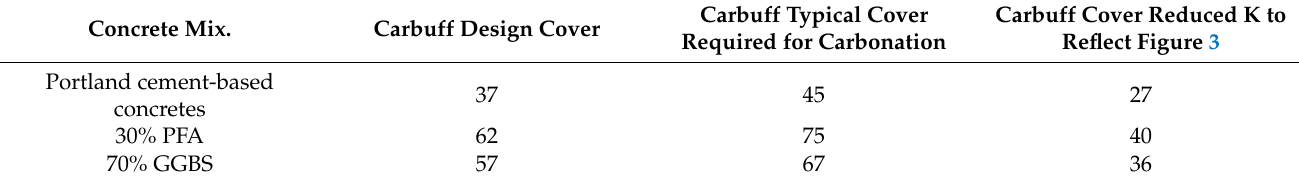
Table 4. Cover required for 100 year life with 450 kg/m 3 cementitious material at 75% RH (700 ppm CO 2 ).